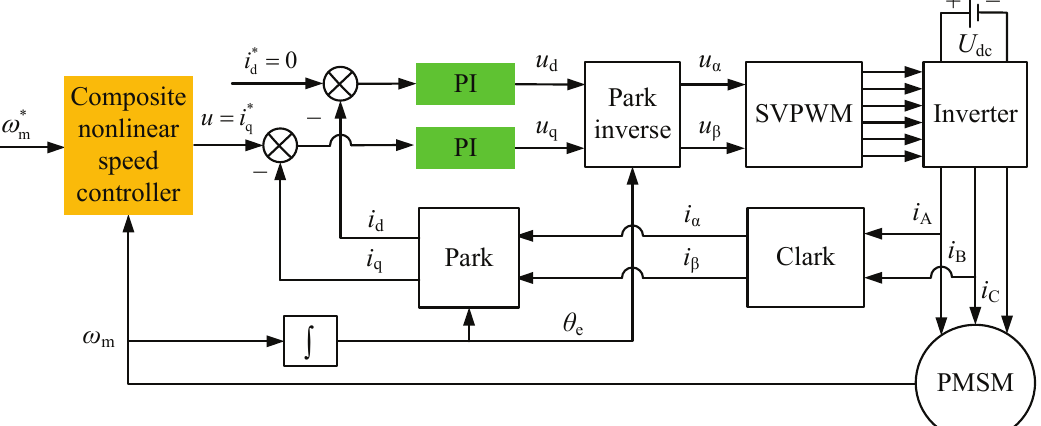
Figure 2. The overall control block diagram for a PMSM regulation system.